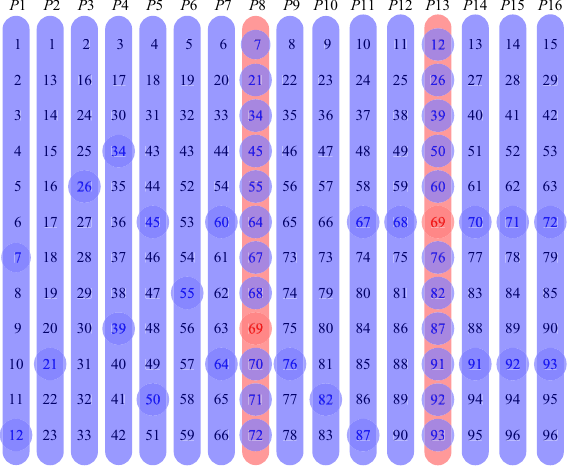
Figure 2. OptReplica